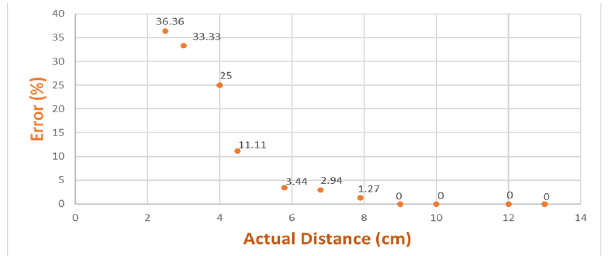
Fig.12 Evaluation of error for metal